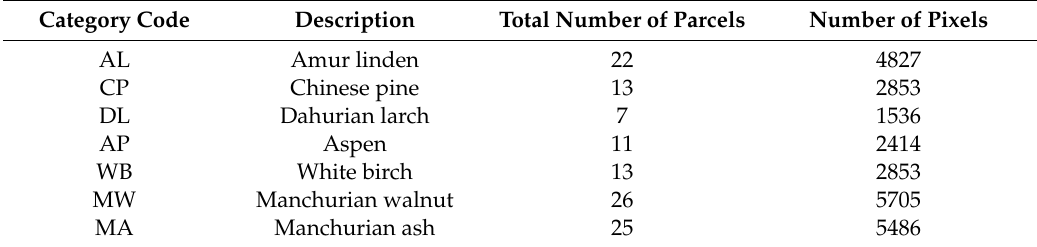
Table 1. Ground reference data in units of pixels for each of the classes